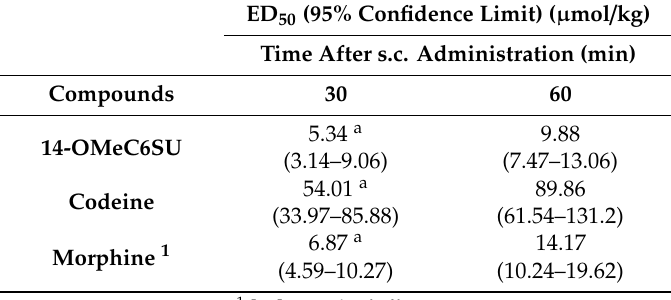
Table 6. Antinociceptive potencies (ED 50 ) of 14-OMeC6SU and codeine against radiant heat induced nociception in rat tail-flick test after 30 and 60 min of s.c. administration. As a reference compound morphine was also